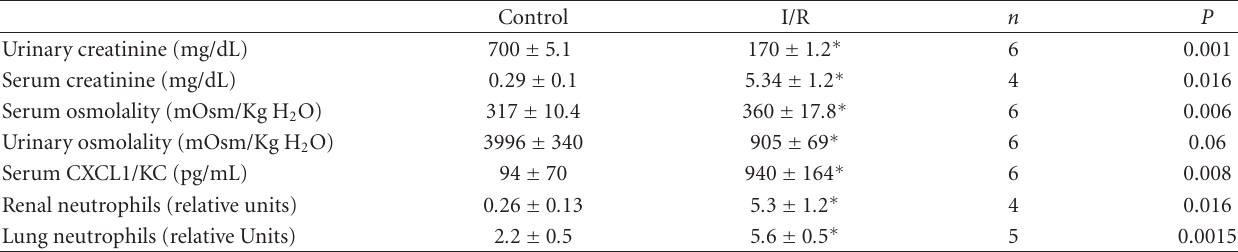
Table 1: E ff ect of renal ischemia and reperfusion on renal function parameters, local CXCL1 production, and local and remote neutrophil accumulation. Urinary creatinine (mg/dL), serum creatinine (mg/dL), serum osmolality (mOsm/Kg H 2 O), urinary osmolality